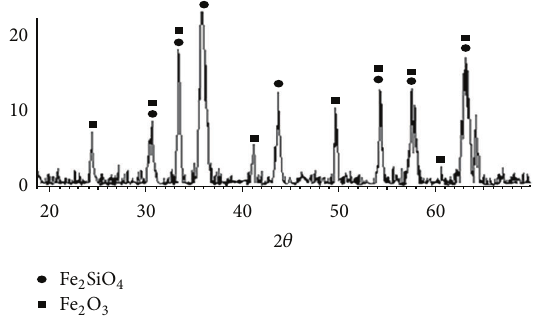
Figure 3: XRD patterns of the Fe/SiO 2